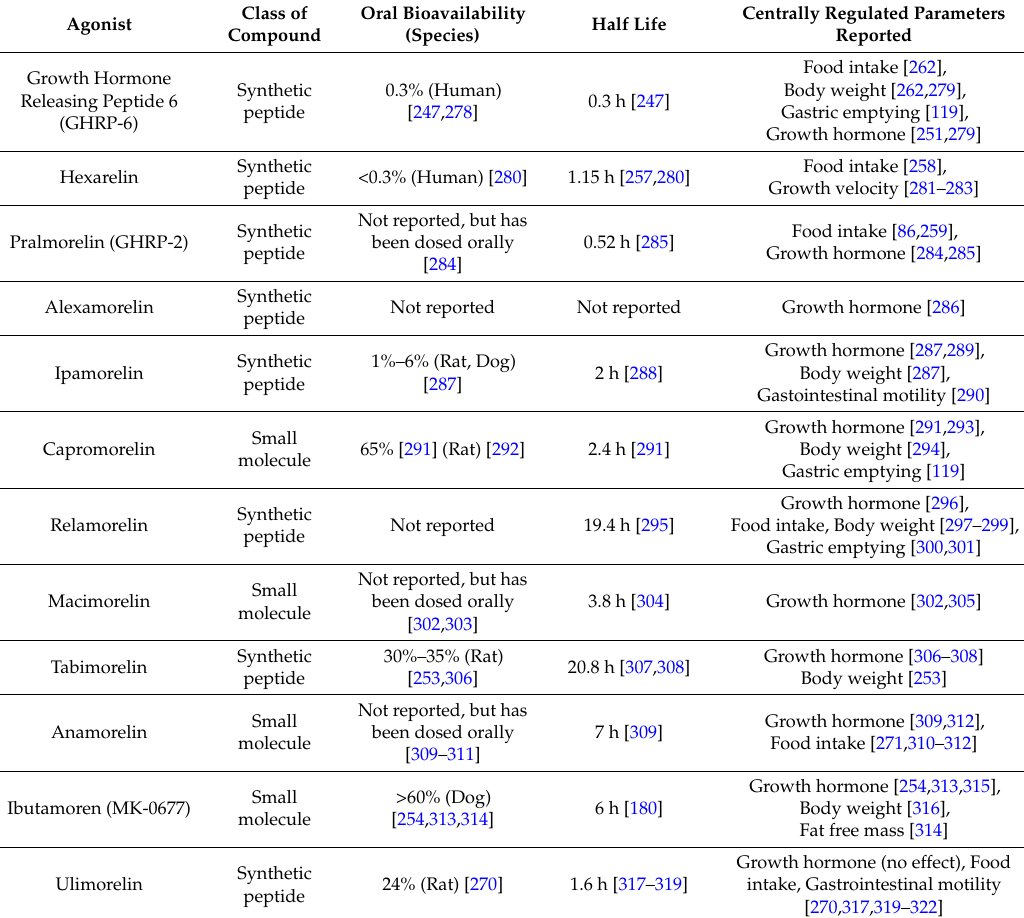
Table 2. Ghrelin agonists used clinically. The half-life, oral bioavailability and